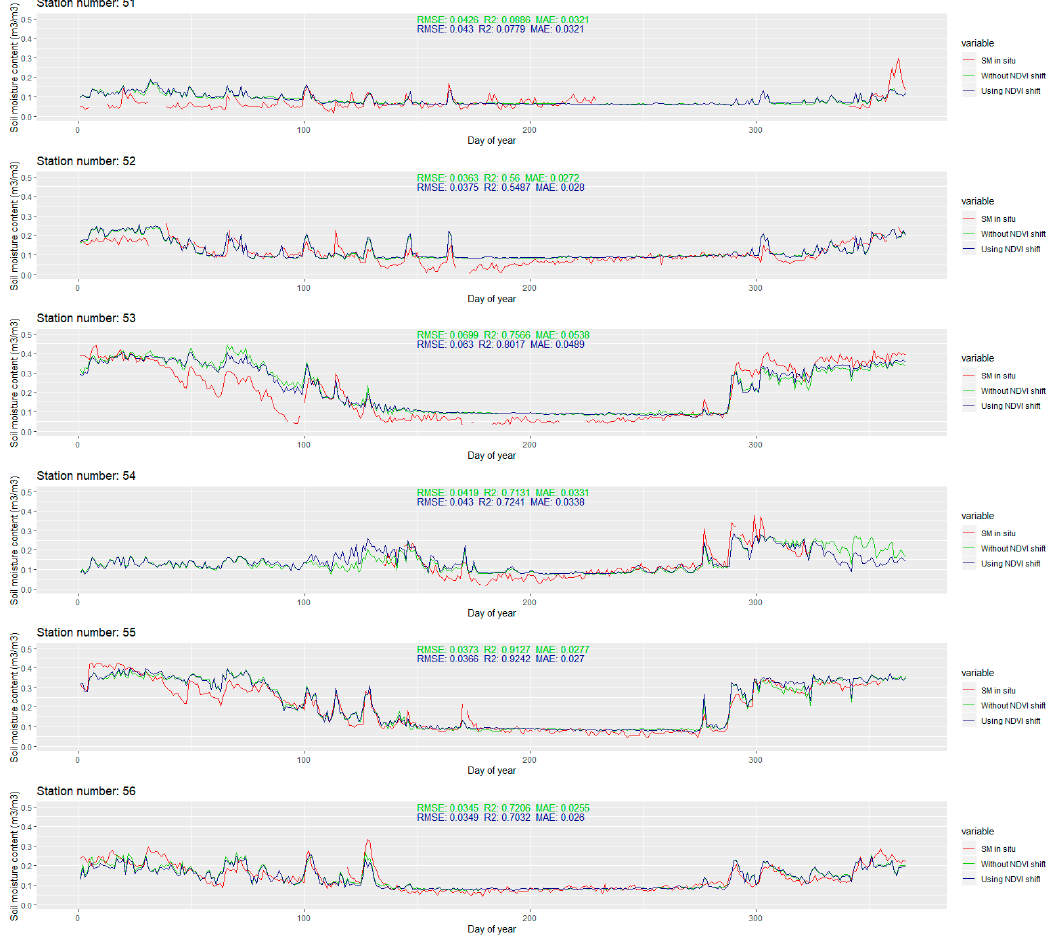
Figure A1. Temporal dynamics of modeled soil moisture against in situ values for each station in the study area.